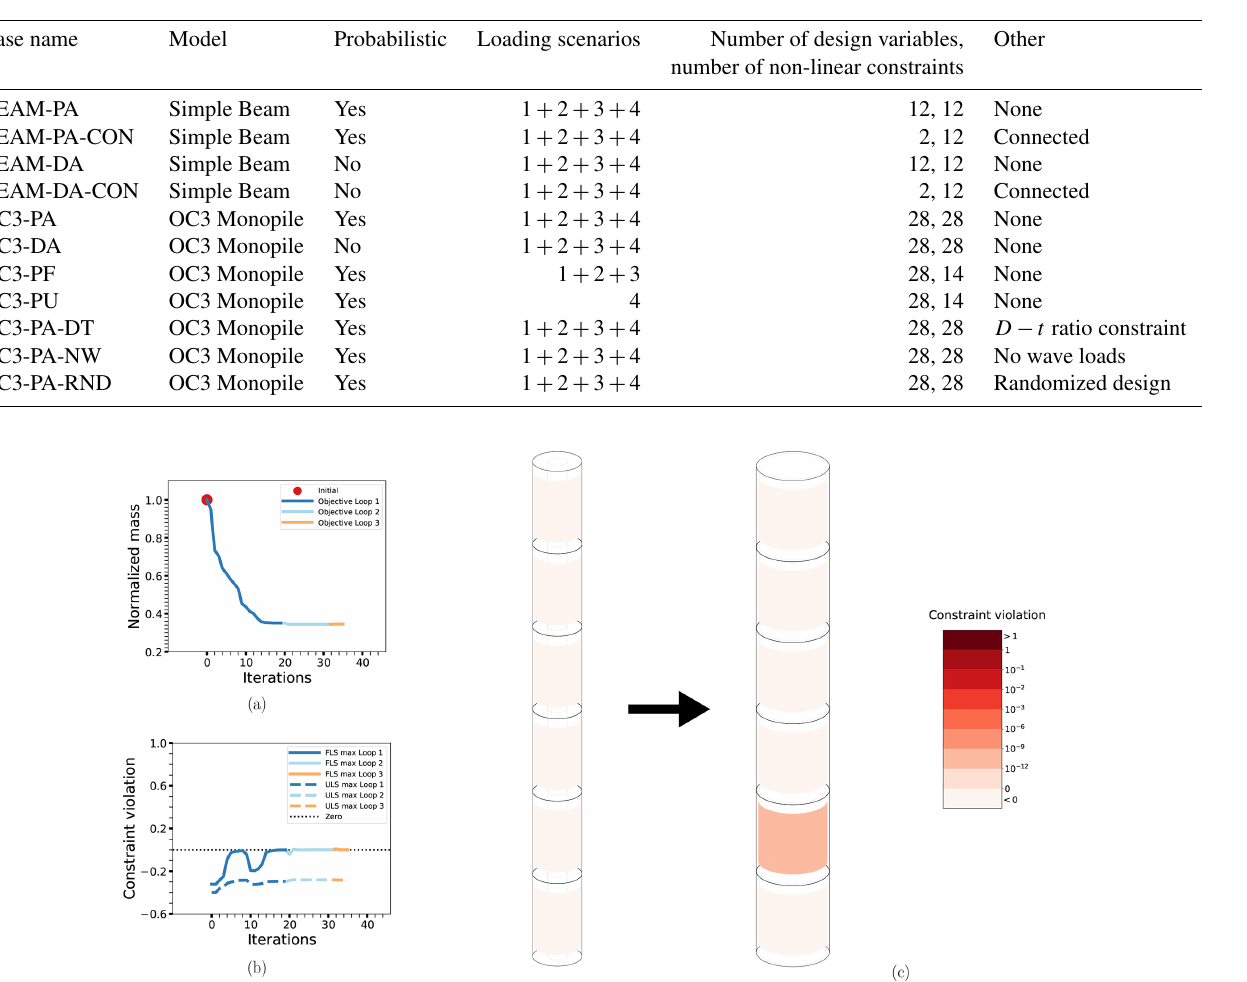
Table 4. Testing cases for RBDO. Loading scenario numbers refer to the values in Table 2.